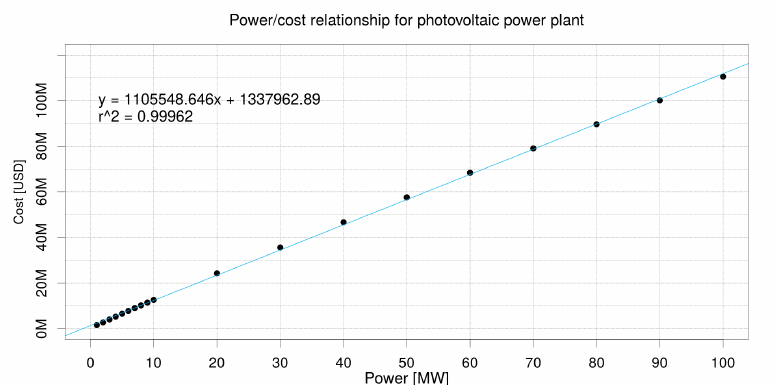
Figure 3. Relationship between power and construction cost for PV power plants.